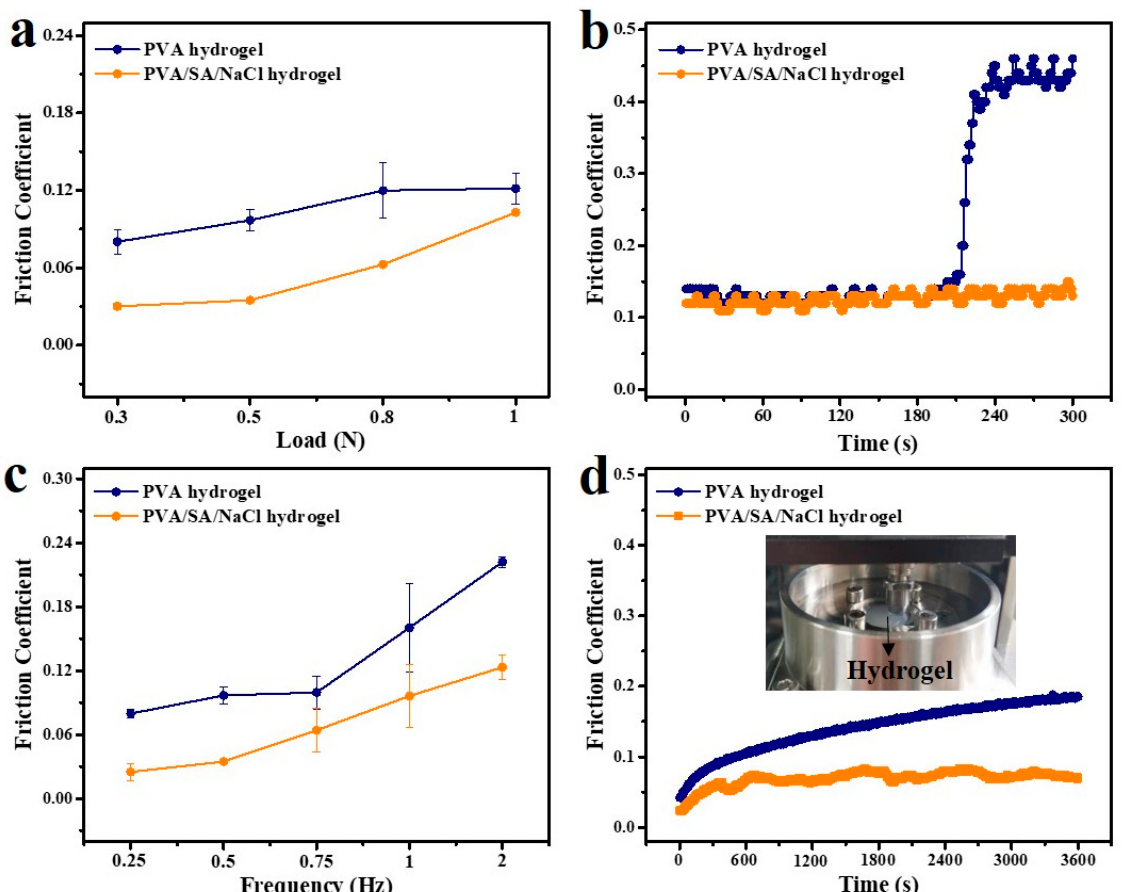
Figure 6. Lubrication properties of the hydrogel. ( a ) friction coefficients of PVA and PVA/SA/NaCl hydrogels under different loads (frequency: 0.5 Hz), ( b ) real-time friction test curves of PVA and PVA/SA/NaCl hydrogels under a normal load of 2 N (frequency: 0.5 Hz), ( c ) friction coefficients of PVA and PVA/SA/NaCl hydrogels for different frequencies (load: 0.5 N), and ( d ) long-time friction test curves of PVA and PVA/SA/NaCl hydrogels (load: 0.3 N, frequency: 0.5 Hz). All friction tests of hydrogels were performed using water as a lubricant and the soft PDMS ball as a sliding pair. Error bars indicate the standard deviation, and n = 3.